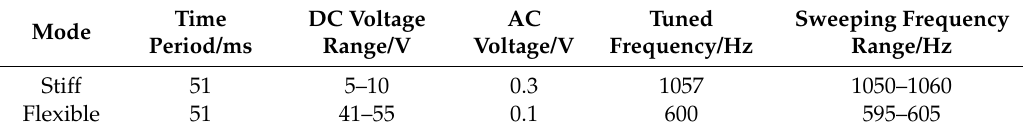
Table 1. Specification of the control system used to tune the frequency in both